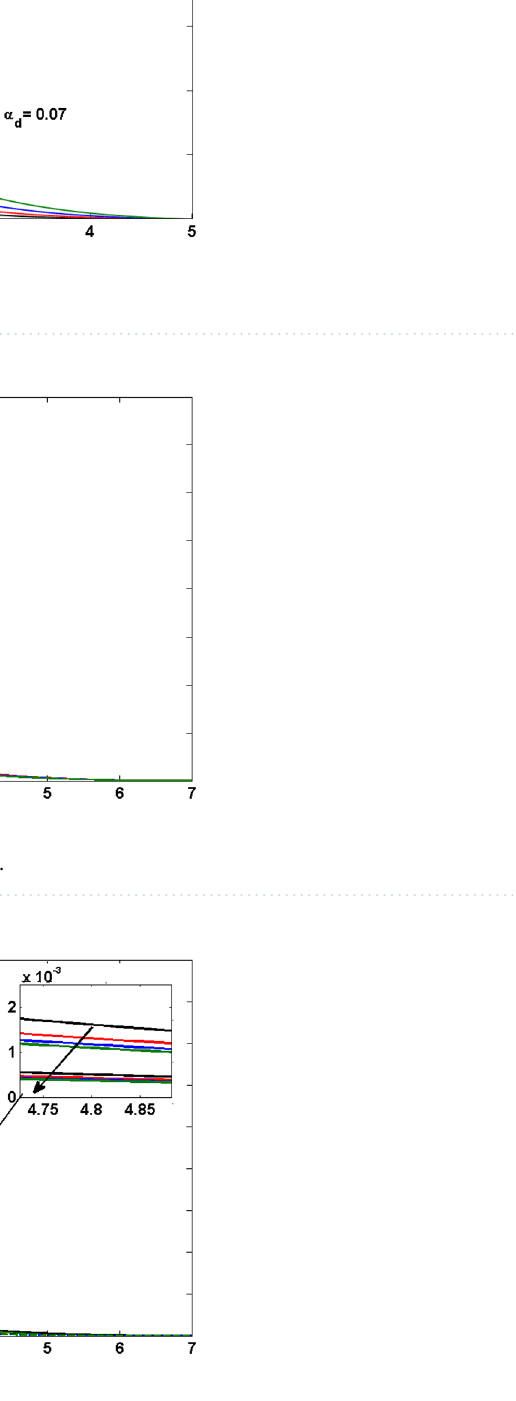
Figure 7. F ′ (η) and F ′ p (η) for various estimates of M